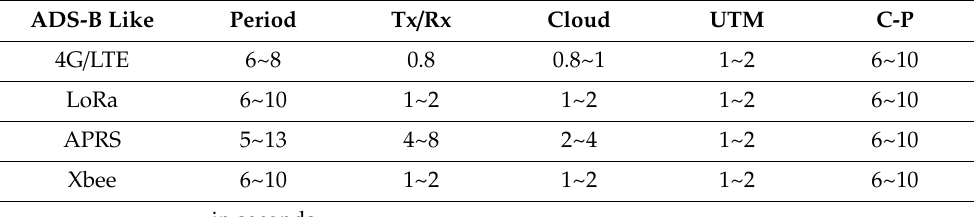
Table 3. Real time delay in